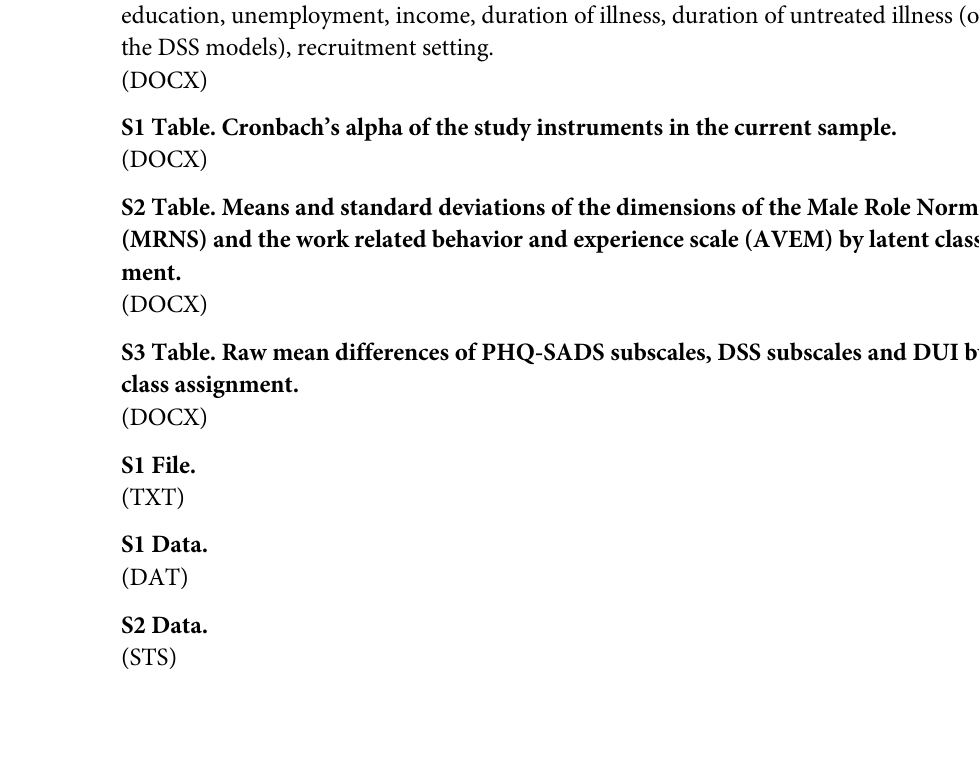
S1 Table. Cronbach’s alpha of the study instruments in the current sample. S2 Table. Means and standard deviations of the dimensions of the Male Role Norms Scale (MRNS) and the work related behavior and experience scale (AVEM) by latent class assign- ment. S3 Table. Raw mean differences of PHQ-SADS subscales, DSS subscales and DUI by latent class